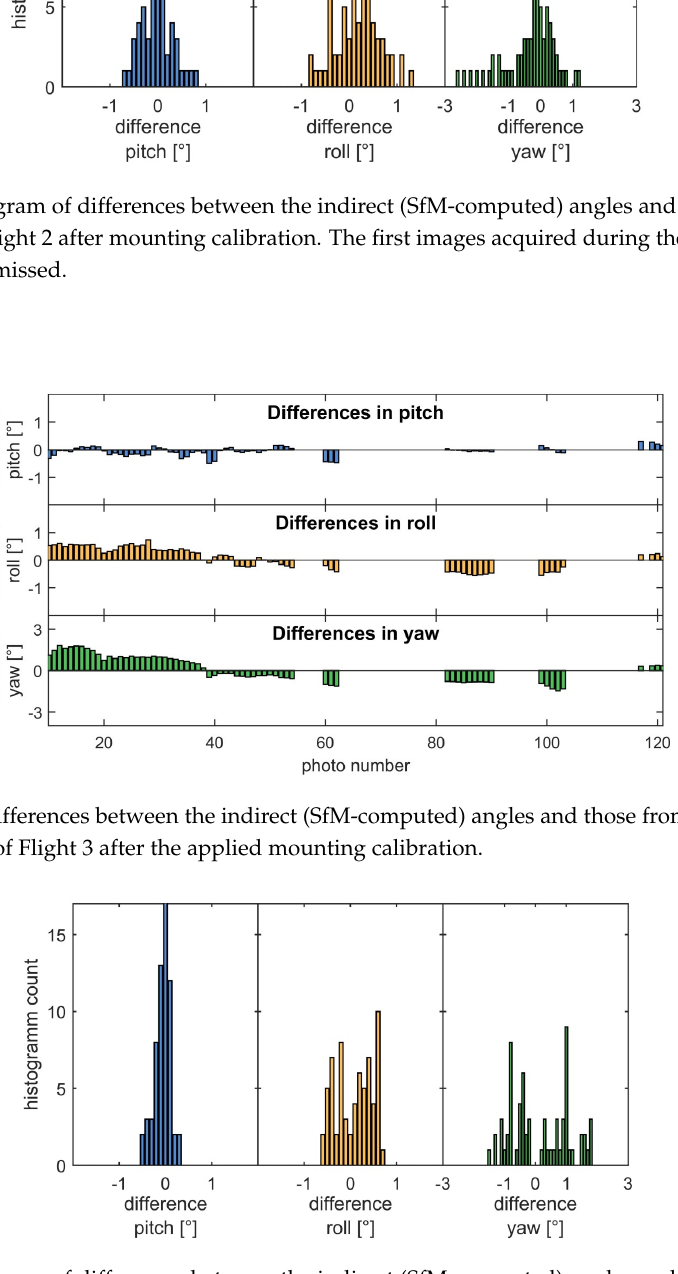
Figure A4. Histogram of differences between the indirect (SfM-computed) angles and those from the GPS/INS from Flight 3 after mounting calibration.